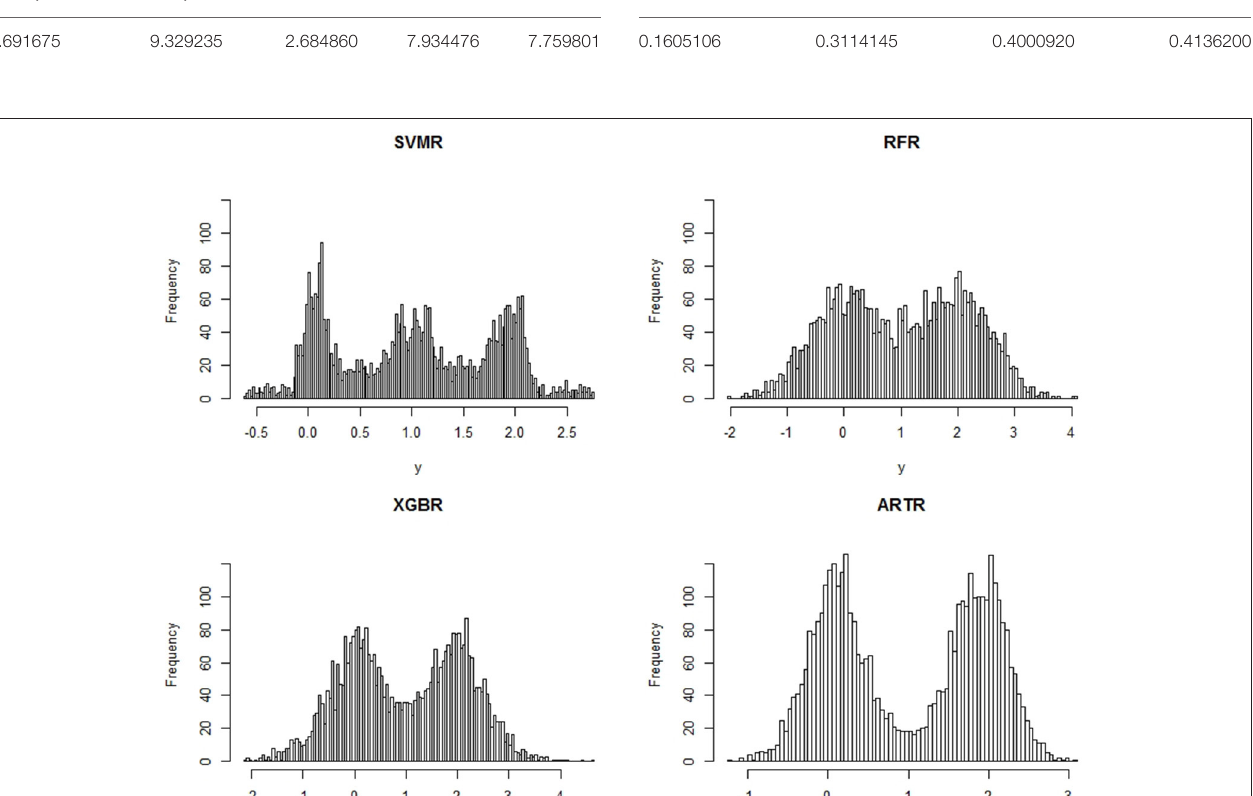
TABLE 1 | The mean squared approximation errors in example 1. ARTR, K=36